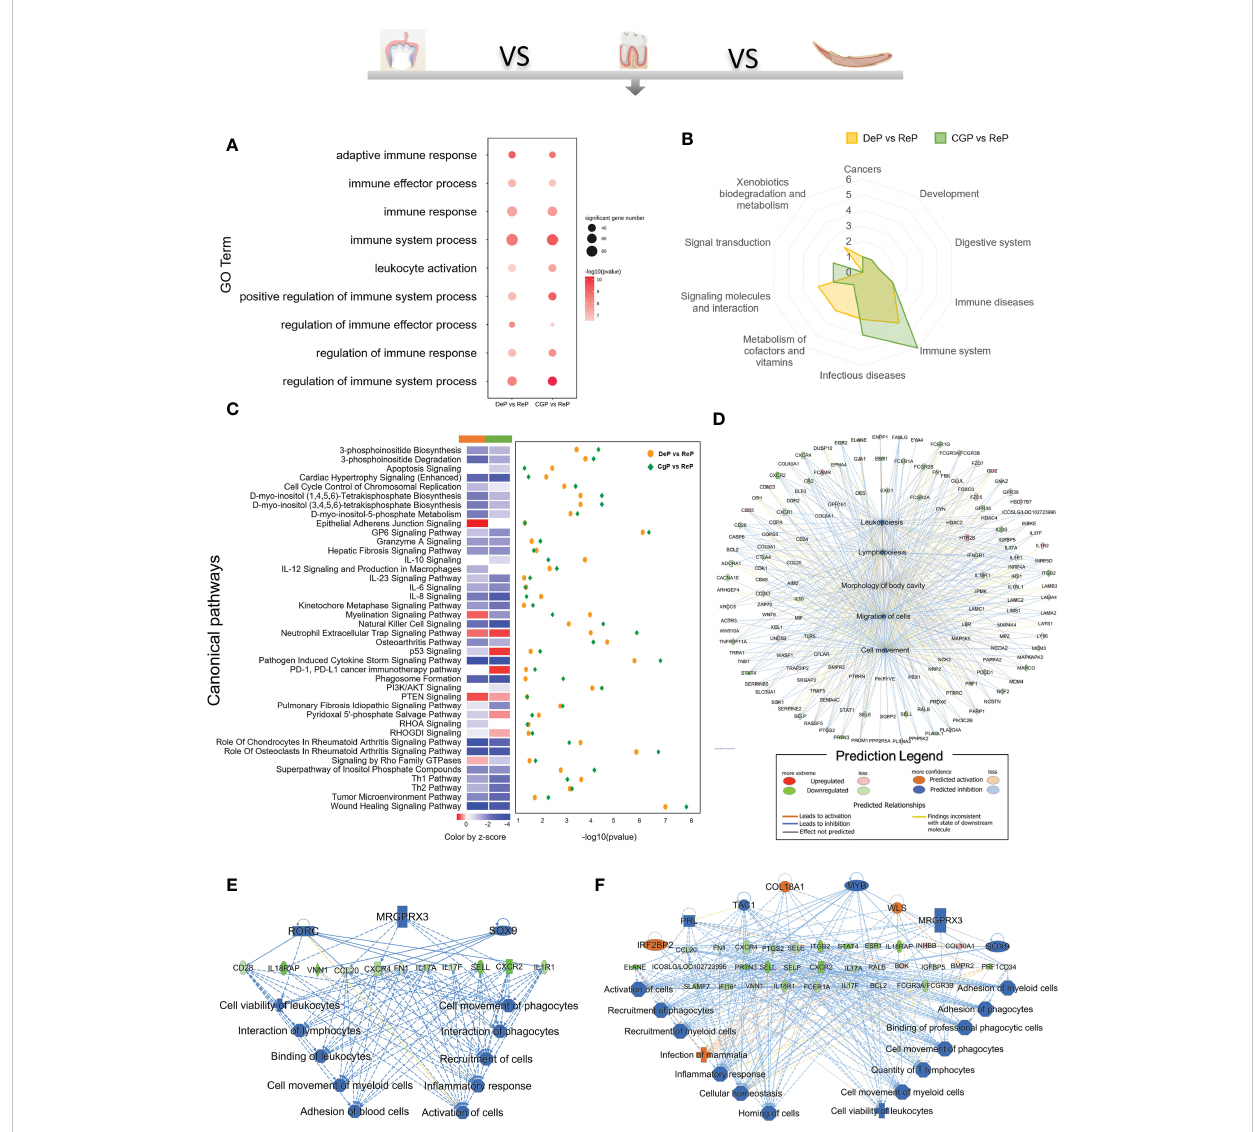
FIGURE 4 GO, KEGG database enrichment analyses, and IPA analysis were used to determine the critical function of the downregulated DEGs in DeP and CgP. (A) In the GO enrichment analysis of downregulated DEGs, immune system-related pathways in the top 20 pathways of DeP and CgP. (B) Radar map of the classi fi cation of the top 20 pathways in KEGG enrichment analysis of DeP and CgP. (C) The common canonical pathways enriched by DeP and CgP DEGs in IPA analysis. The z-score of the pathway is shown in the heat map, and the -log10 (p-value) of the pathway is shown in the scatter map. (D) “ disease and function ” predictions were made based on DEGs involved in common canonical pathways. The fi gure shows the top fi ve functions. (E, F) Network diagram representing the regulatory effects with top consistency scores in DeP (E) /CgP (F) versus